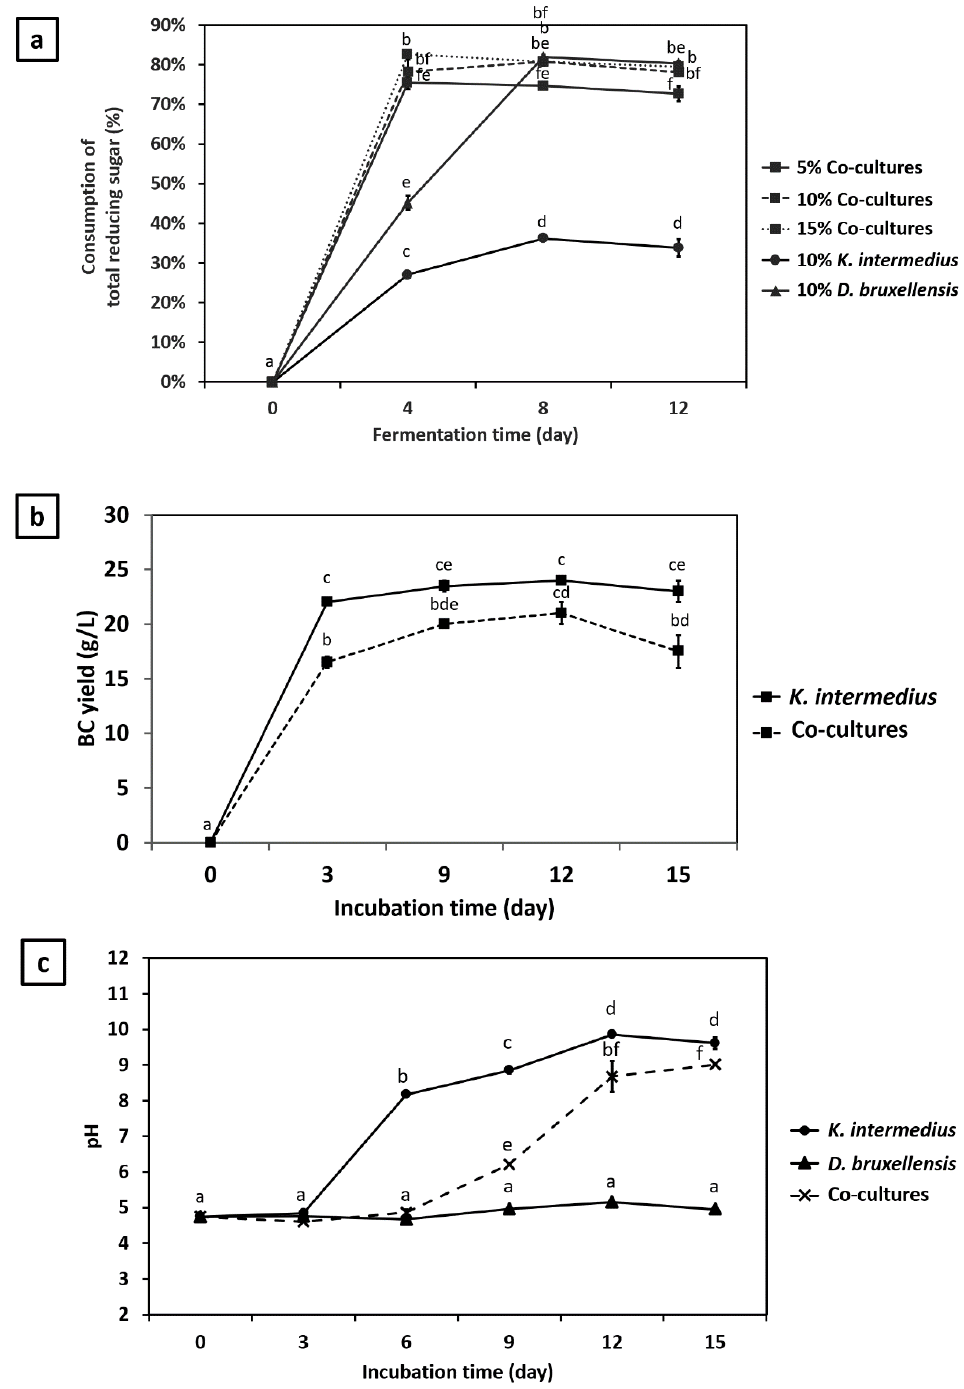
Figure 3. ( a ) Reducing sugar consumption by single and co-culture varying in inoculum sizes (5%, 10%, 15% v / v ); ( b ) BC yield and ( c ) pH changes during single and co-culture fermentation using yield and ( c ) pH changes during single and co-culture fermentation using inoculum size of 10% v / v . Culture conditions: inoculum size of 10% v / v . Culture conditions: media composition, 150 g/L molasses, 500 mg/L caf- media composition, 150 g/L molasses, 500 mg/L caffeine, acetate buffer (200 mM, pH 4.75); K. intermedius : D. bruxellensis feine, acetate buffer (200 mM, pH 4.75); K. intermedius : D. bruxellensis ratio, 1:1; temperature, 30 °C. ratio, 1:1; temperature, 30 ◦ C. Means with different letters are significantly different ( p < Means with different letters are significantly different ( p < 0.05).